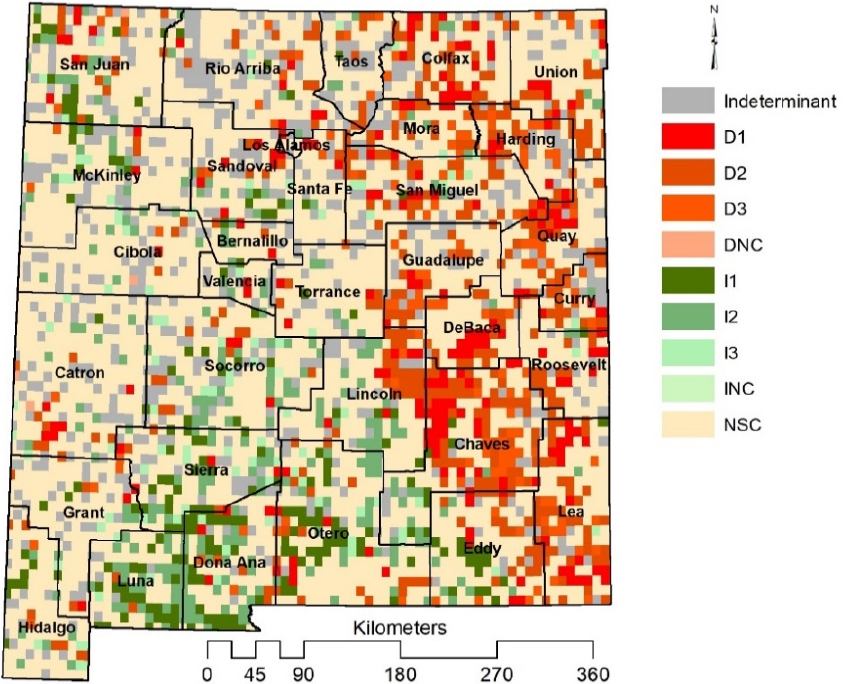
Figure 4. The spatial distribution, significance, and direction of change in productivity using TSS- RESTREND (1982–2015). Bands of red (D1, D2, D3, D4) and green (I1, I2, I3, and INC) pixels indicate those with decreasing and increasing trends in productivity, respectively. NSC (yellow) and indeterminant (gray) pixels were those with non-significant and unidentified change, respectively.